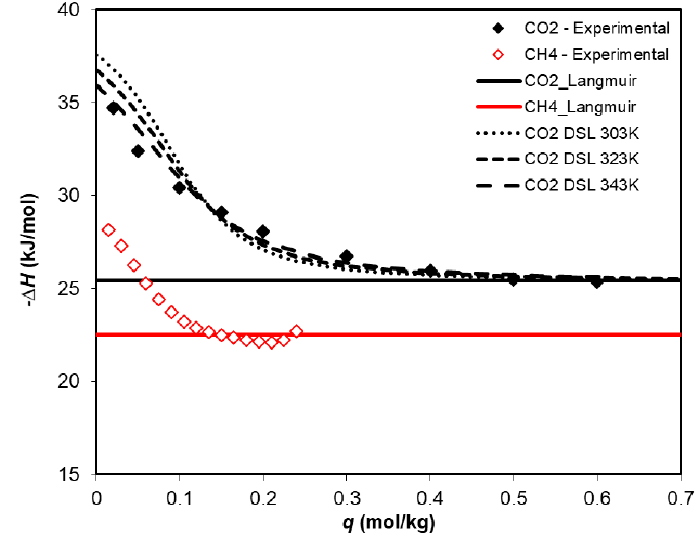
Figure 9. Isosteric heat as a function of loading for CO 2 and CH 4 on ZSM-5. The closed and open symbols denote the isosteric heat calculated from the isosteric data derived from the experimental adsorption isotherms for CO 2 and CH 4 , respectively. The solid lines represent the isosteric heat obtained from the Langmuir fitting; the dashed lines represent the values obtained with the DSL for CO 2 .